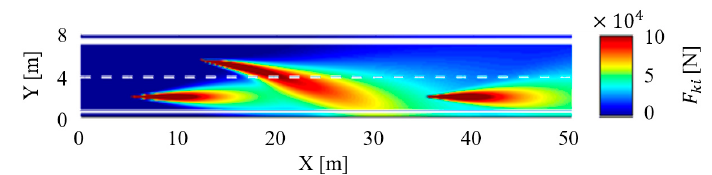
Figure 12. The time-varying traffic risk map in the cut-in scenario.